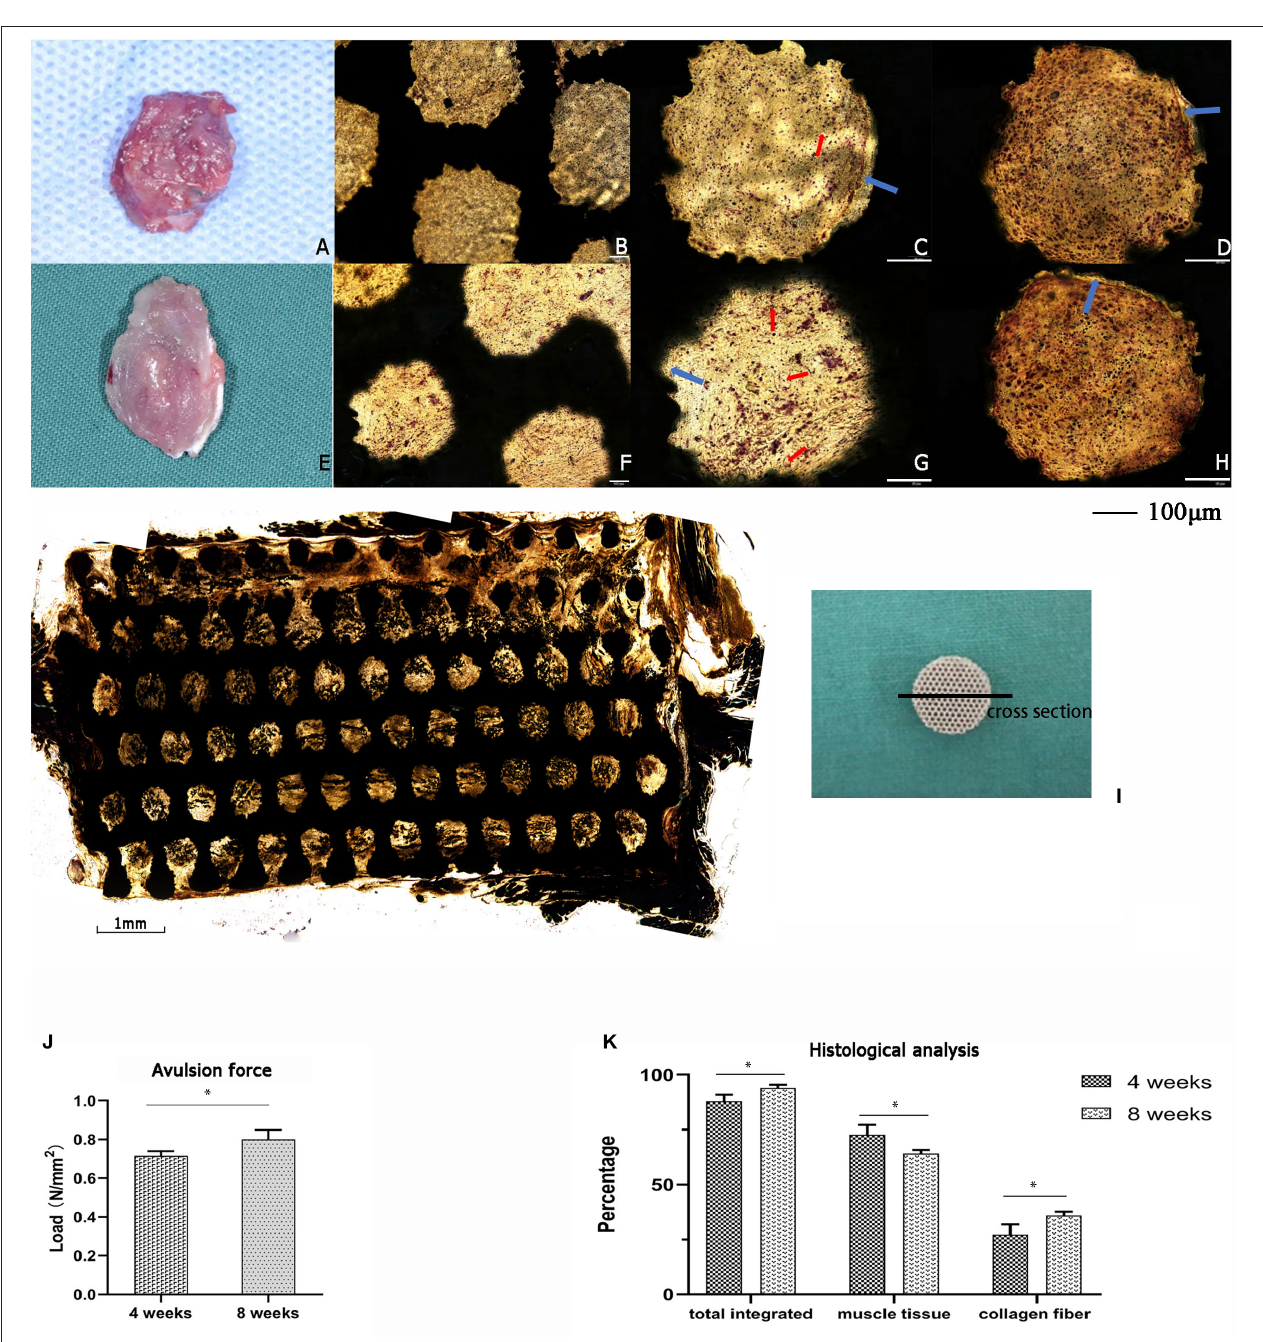
FIGURE 5 | The implantation of titanium scaffold into the intervertebral muscle of rats. (A–D) The specimen of 4 weeks, (A) Gross specimen, (B) hard slicing with V-G staining, 10 x, (C,D) hard slicing with V-G staining, 20 x; (E–H) The specimen of 8 weeks, (E) Gross specimen, (F) hard slicing with V-G staining, 10 x, (G,H) hard slicing with V-G staining, 20 x. Blue arrow: the blank gap between tissue and pore, red arrow: the newly formed capillary. (I) Histologic cross-section at 8 weeks showing the ingrowth of muscle tissue into the scaffold,4 x. (J) The avulsion force of titanium scaffold implanted in rats for 4 and 8 weeks; with a significant increase in 8 weeks (* p < 0.05). (K) The histological analysis of the tissue integrated percentage and distribution in rats. The data are presented as the mean ± SD (* p < 0.05).